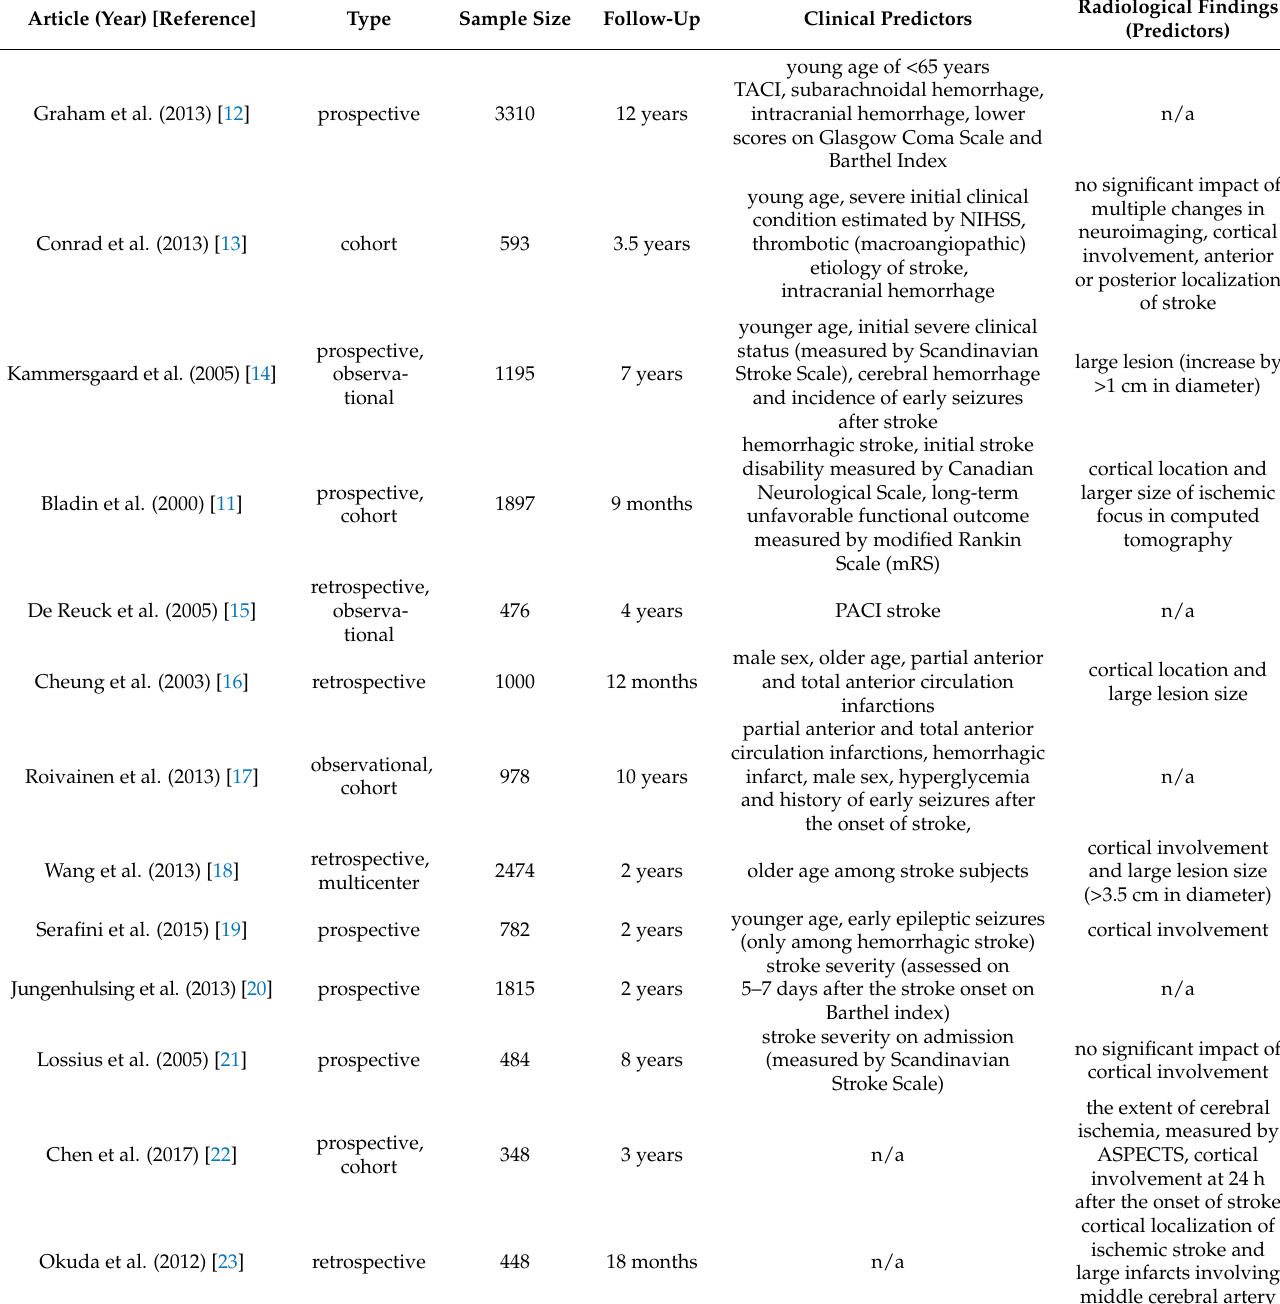
Table 1. Summary of the most relevant papers regarding clinical and radiological predictors of poststroke